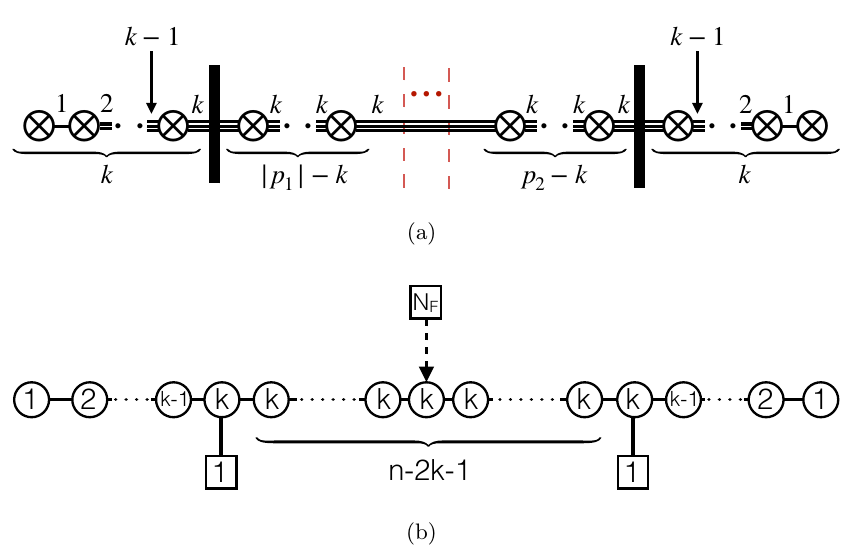
Figure 20 . (a) A HW frame from which we can read o(cid:11) the SQM quiver for k (cid:20) min fj p 1 j ; p 2 g . (b) The SQM quiver theory realized on the D1-branes in (cid:12)gure 20(a). v = ( p + k; p (cid:0) k ) is realized by introducing k D1-branes between the two D3-branes. 1 2